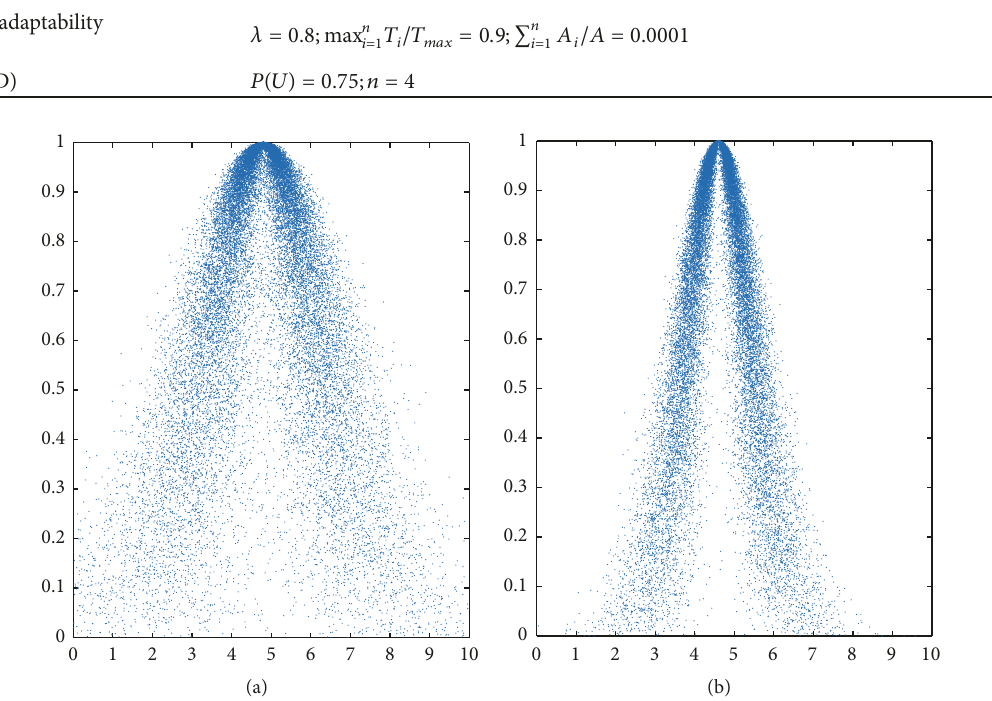
Figure 2: The weight of “information sharing”: (a) represents the first cloud weight, and (b) indicates the final best cloud